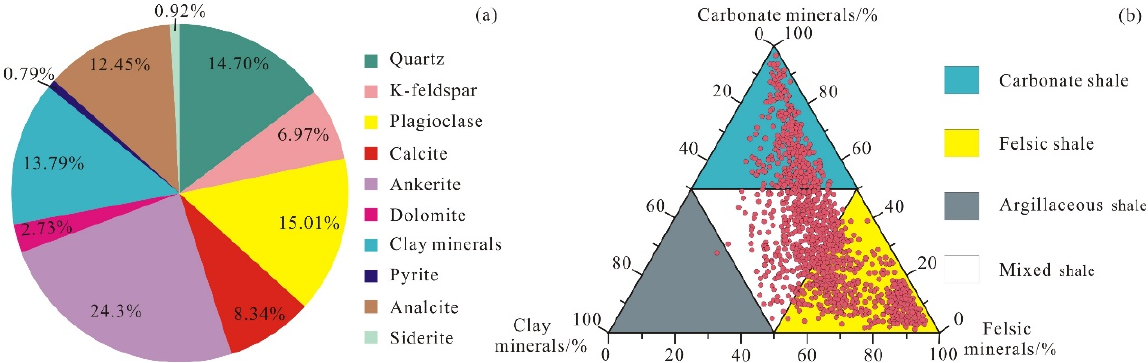
Figure 4. Mineral compositions of the Ek 2 shales in the Cangdong Sag. ( a ) Pie diagram. ( b ) Ternary diagram.